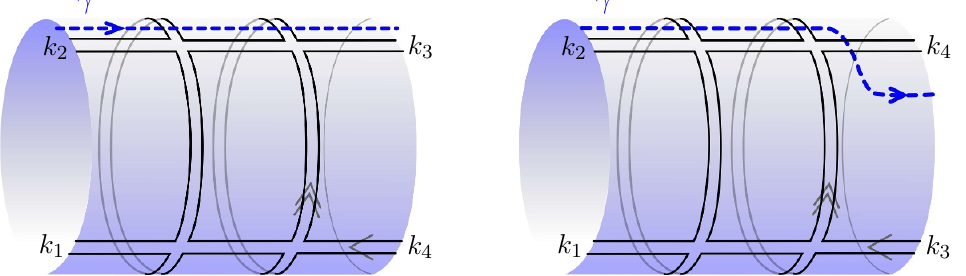
Figure 6 . The two diagrams that contribute to the double trace amplitude (3.6) at three-loop order. The blue line represents the cylinder cut of these